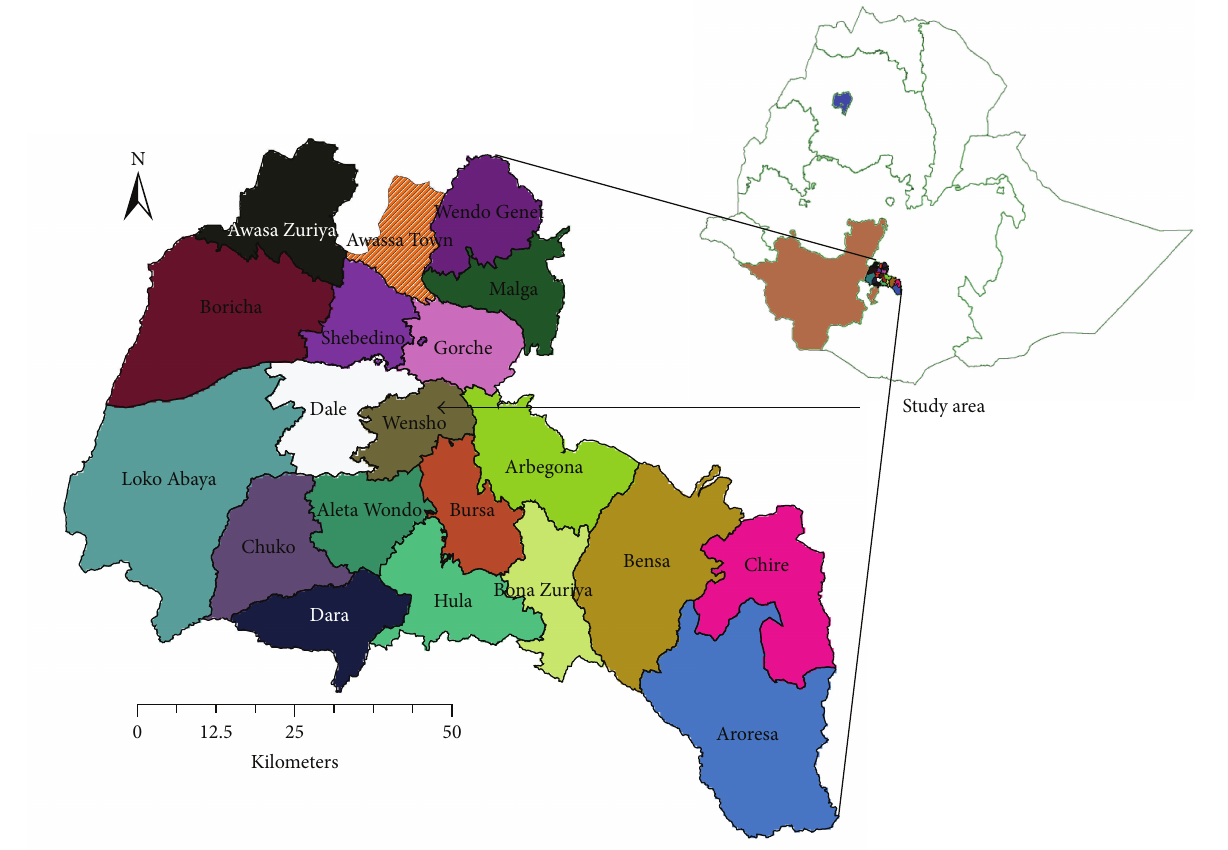
Figure 1: Map of the study